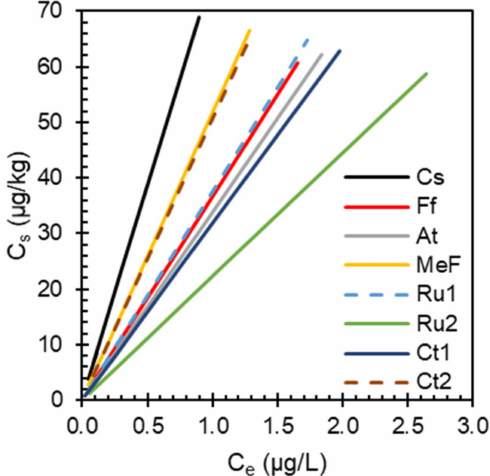
Figure 3. Best-fit linear isotherms for all samples (At, Alligator Association; Cs, channel sand; Ct1, Cuthbert Series A horizon; Ct2, Cuthbert Series B horizon; Ff, Falaya Silt Loam Series; MeF, Memphis Silt Loam Series; Ru1, Ruston Series A horizon; Ru2, Ruston Series E horizon).